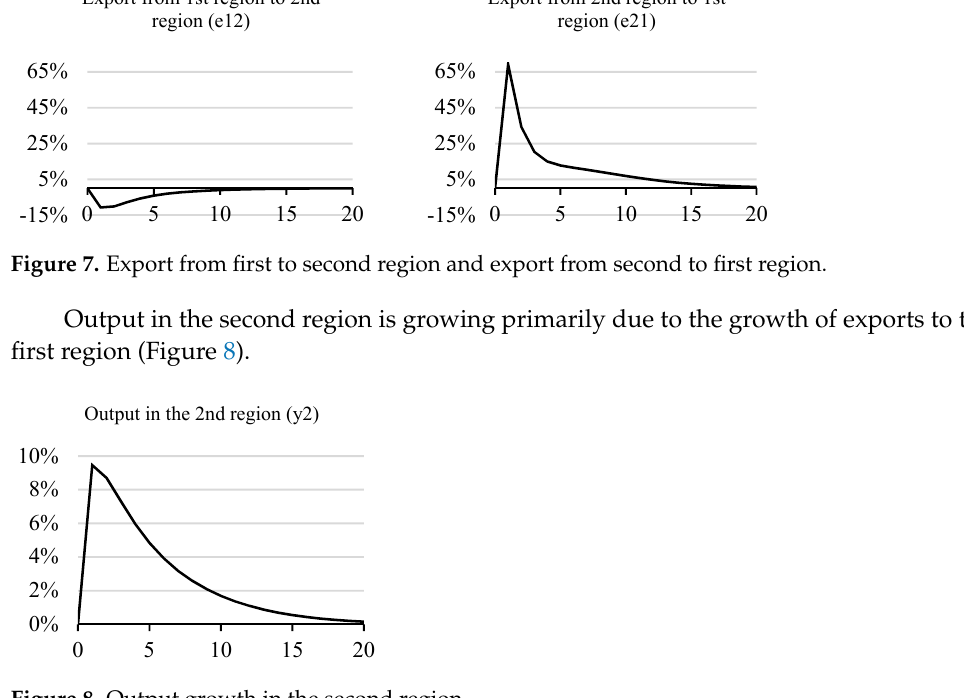
Figure 9. Growth of budget revenues and expenditures in the second region. The growth of current budget purchases reinforces the positive output gap. Moreo- ver, the growth of human capital expenditures raises the aggregate factor productivity (Figure 10). Figure 10. Growth of budget revenues and expenditures in the second region. In the labor market (Figure 11), there is simultaneously an increase in the demand for labor against the background of the expansion of production and an increase in the supply of labor due to an increase in healthcare costs. The second effect outweighs the first; as a result, wages are reduced. Consumption is declining as a result of a reduction in wages and an increase in the interest rate (see below).